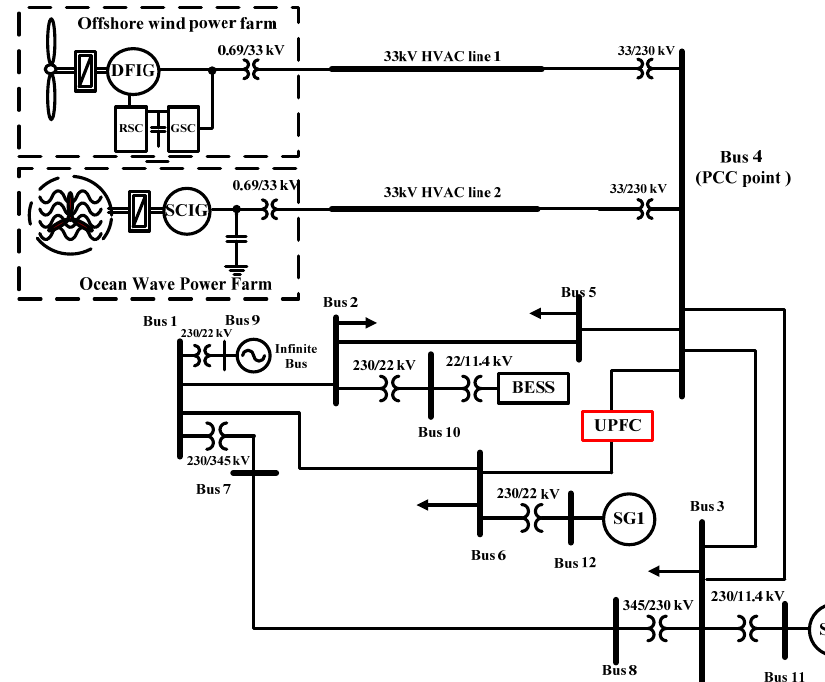
Figure 1. Power grid configuration diagram based on multi energy including